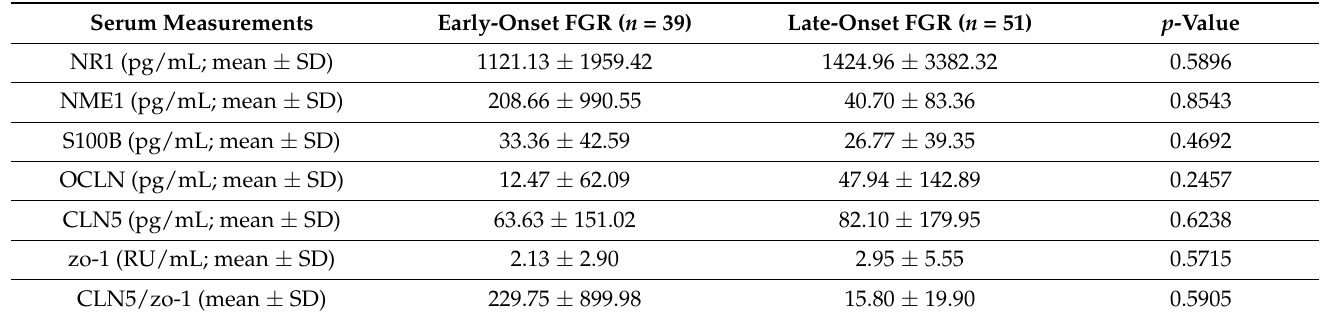
Table 3. Serum measurements in pregnancies complicated by the early-onset and late-onset FGR.